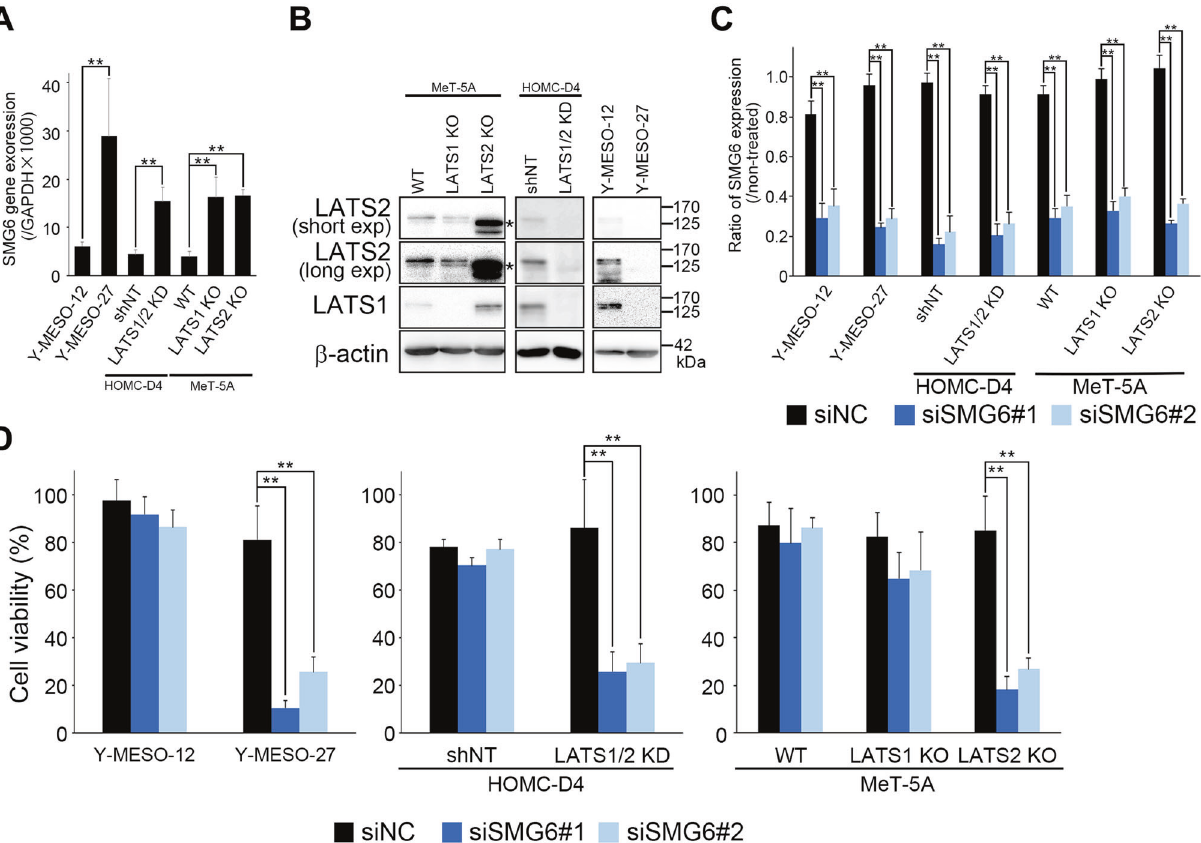
Fig. 2 Knockdown of SMG6 reduces the viability of LATS2-inactive cells. A The mRNA expression levels of SMG6. B The protein expression levels of LATS1 and LATS2. * indicates a nonspeci fi c band. C The knockdown ef fi ciency of SMG6 mRNA. D Cell viability when SMG6 is knocked down. Cell viability was measured 72 h after siSMG6 treatment using CCK-8. All experiments were performed at least three independent times. Data are presented as means ± SD, and p values were calculated using the Tukey-Kramer method. ** indicates p <